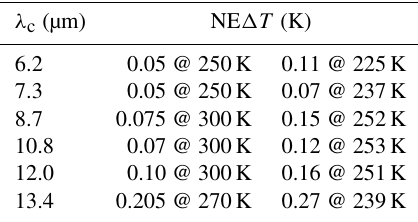
Table 1. Radiometric noise estimates of MSG-2/SEVIRI thermal channels (first column, including the channel centre wavelength λ c ) at the reported reference brightness temperatures (second col- umn; EUMETSAT, 2007) and at typical brightness temperatures observed for cirrus cloud retrievals (third column, see Sect.